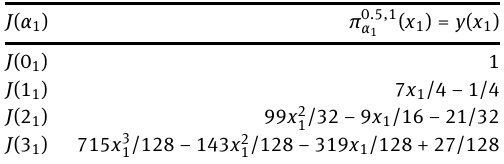
Table 3: Basis for the first state variable x 1 . Solution to the Jacobi ODE with parameters η = 0.5 and ν = 1